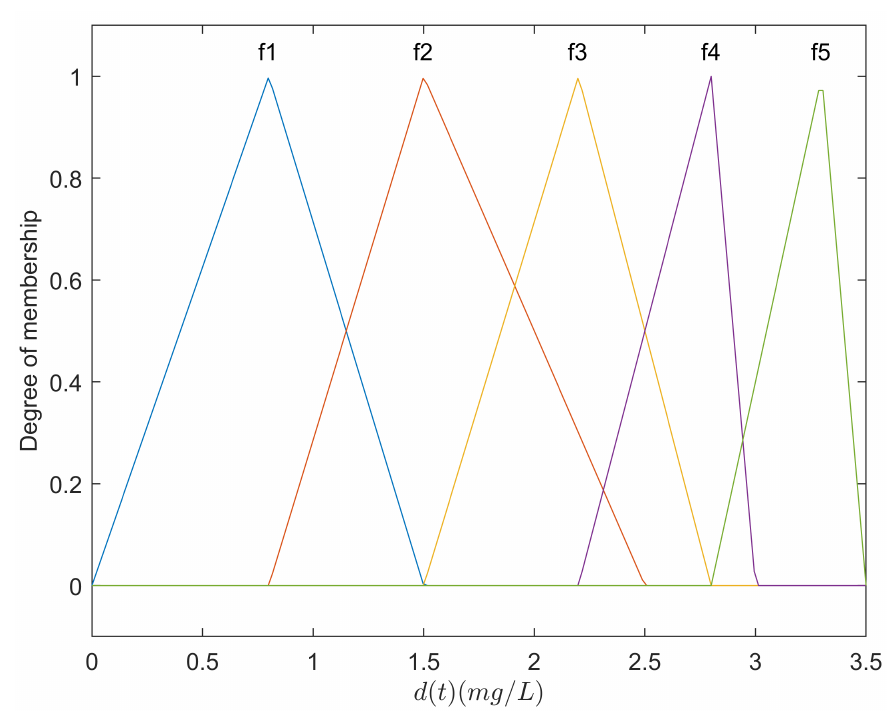
Figure 4. Membership function of d ( t )